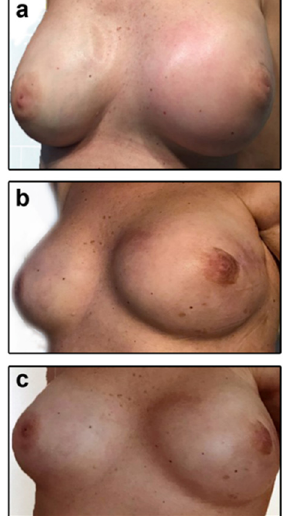
Figure 12. Seroma-related left breast swelling in a 56-year-old breast cancer survivor. ( a ) A diffuse edema with erythematous skin localized on the left side of breast was evident at baseline. ( b ) After 16-week adapted physical activity intervention, edema was reduced. ( c ) At the end of the whole physical activity protocol, the patient had no symptoms and signs of seroma. As shown in the picture, left breast looked like a normal one without breast swelling and skin changes similarly to the contralateral side.